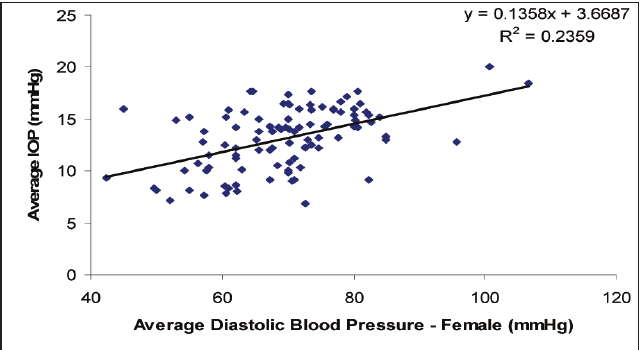
Figure 8 : Relationship between average IOP and average diasto- lic BP in